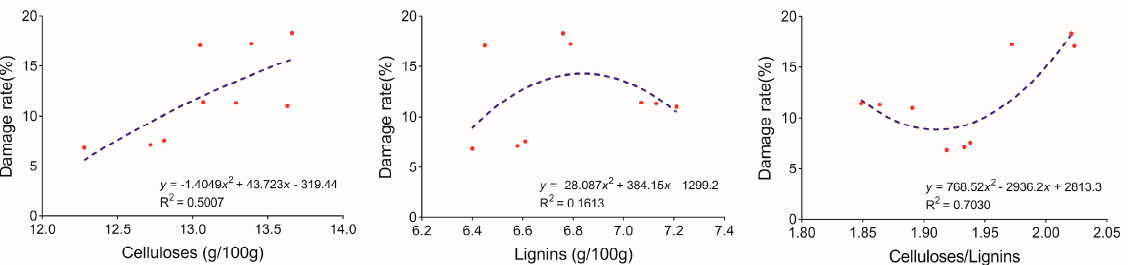
Figure 5. Regression analysis of hazelnut damage rate with cellulose contents, lignin content, and the ratio of cellulose − to − lignin in nutshell after damaged by C. nucum .